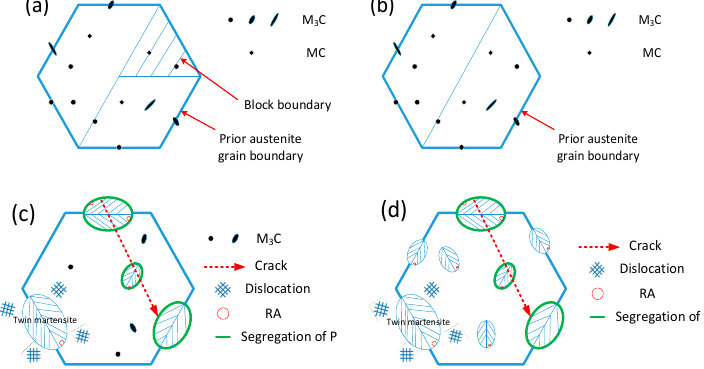
Figure 10. Schematic representation for microstructure and precipitates of SA738 Gr.B under different ◦ C; ( b ) 650 ◦ C; ( c ) 690 ◦ C; ( d ) 710 ◦ tempering temperatures: ( a ) 630 °C; ( b ) 650 °C; ( c ) 690 °C; ( d ) 710 °C. tempering temperatures: ( a ) 630